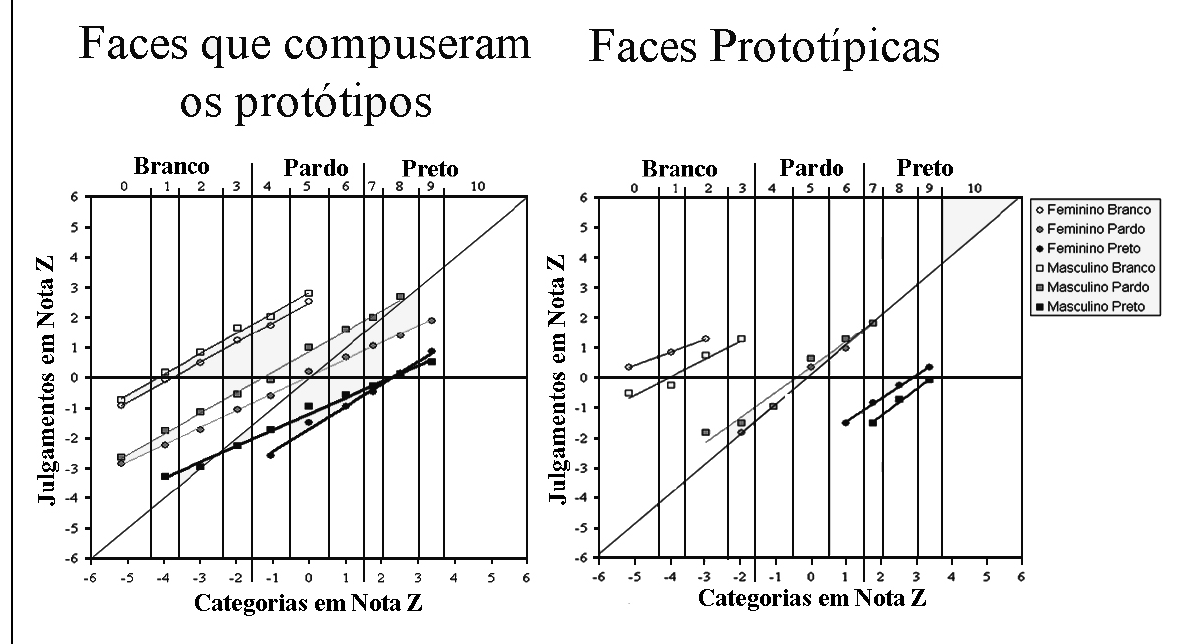
Figura 4 . Retas de regressão das médias dos julgamentos de tipicidade de cor heteroatribuídos, em nota z reduzida, em função das categorias de tipicidade de cor, também em nota z, para as imagens das faces prototípicas e das faces que as compuseram. Os ângulos de inclinação das retas indicam as variabilidades dos julgamentos heteroatribuídos e as interceptações das retas com o eixo